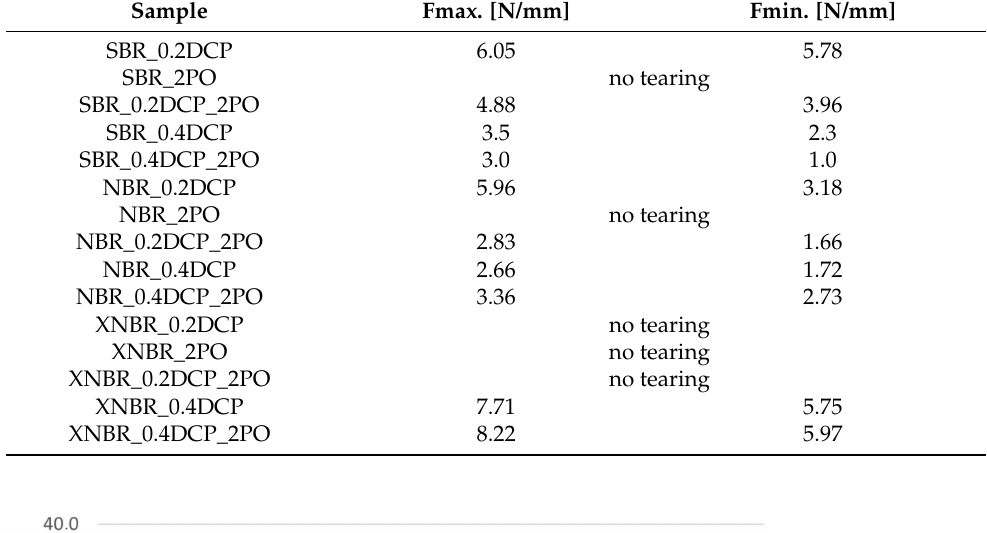
Table 4. Tear strength of the rubber samples tested.